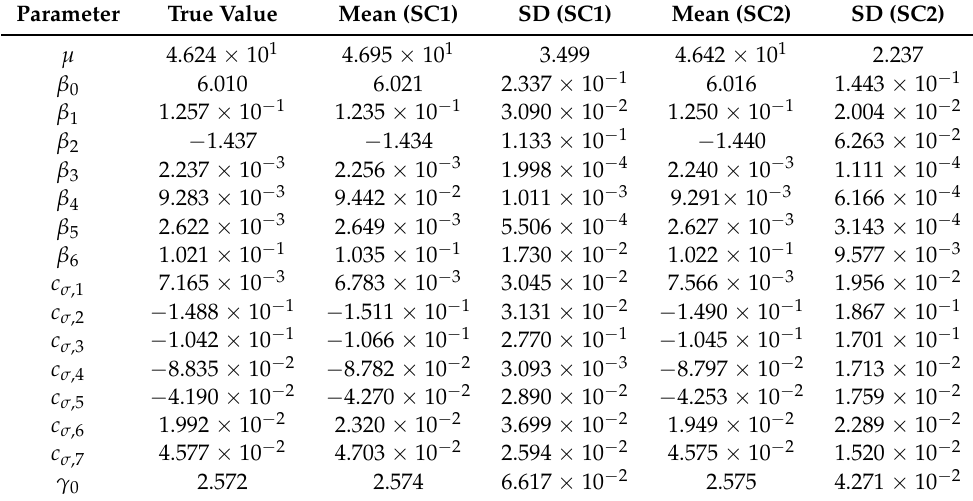
Table 3. Performance of MLE with the sample sizes of 2000 (SC1) and 5000 (SC2). Mean and SD are samples means and standard derivations of 500 estimated corresponding parameter values